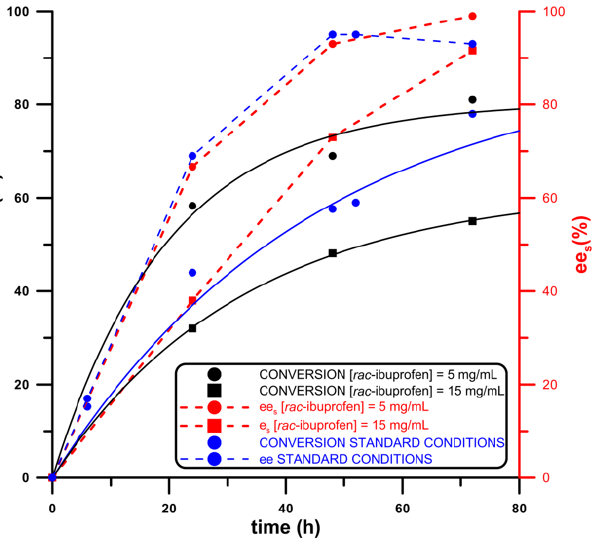
Figure 8. Kinetics of the esterification of rac - ibu profen at different concentrations. Experimental data in Table 4.